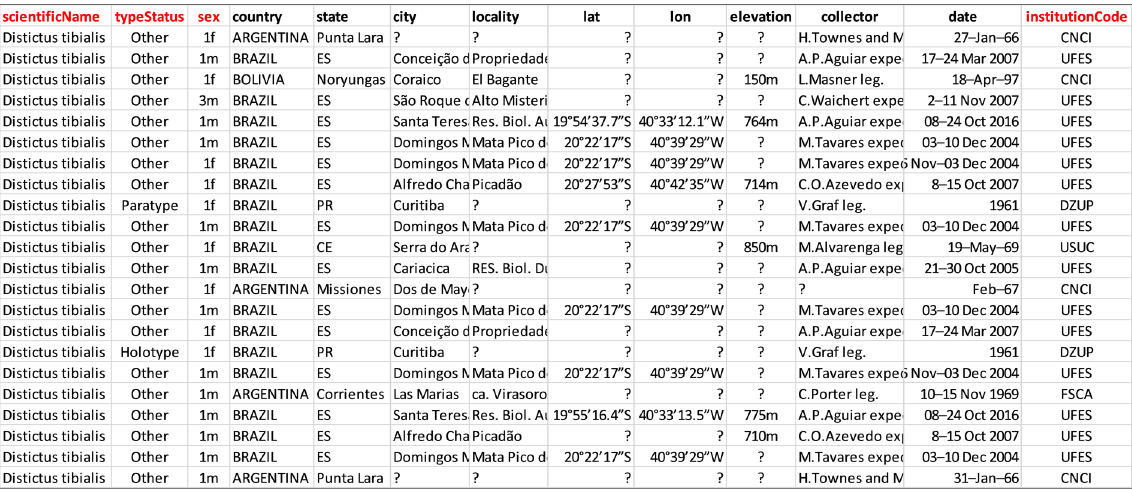
Fig. 2. Columns swapped according to the desired order for the information in the final text. The order of the column names (scientificName, typeStatus, sex, country, etc.) corresponds to the variable Display Order in the Gridit